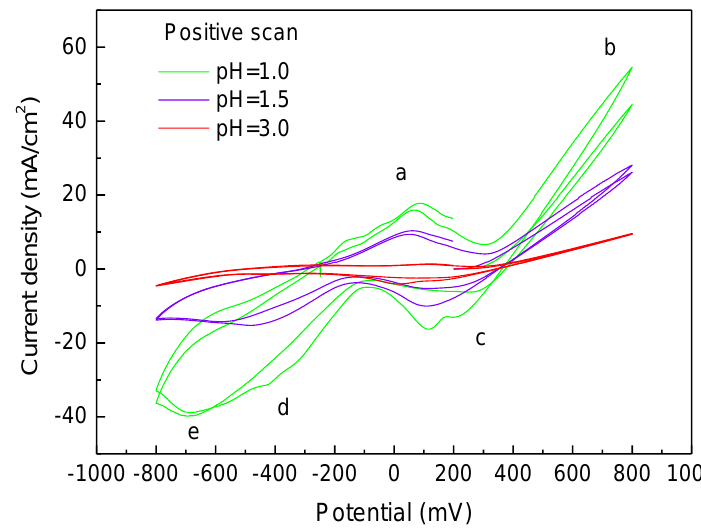
Figure 3. Cyclic voltammetry spectra of the bornite electrode at different pHs.